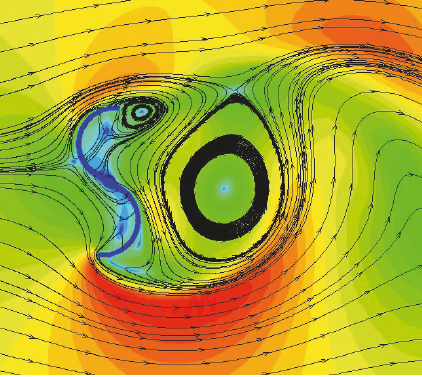
Figure 6: Flow past autorotating Savonius rotor with two